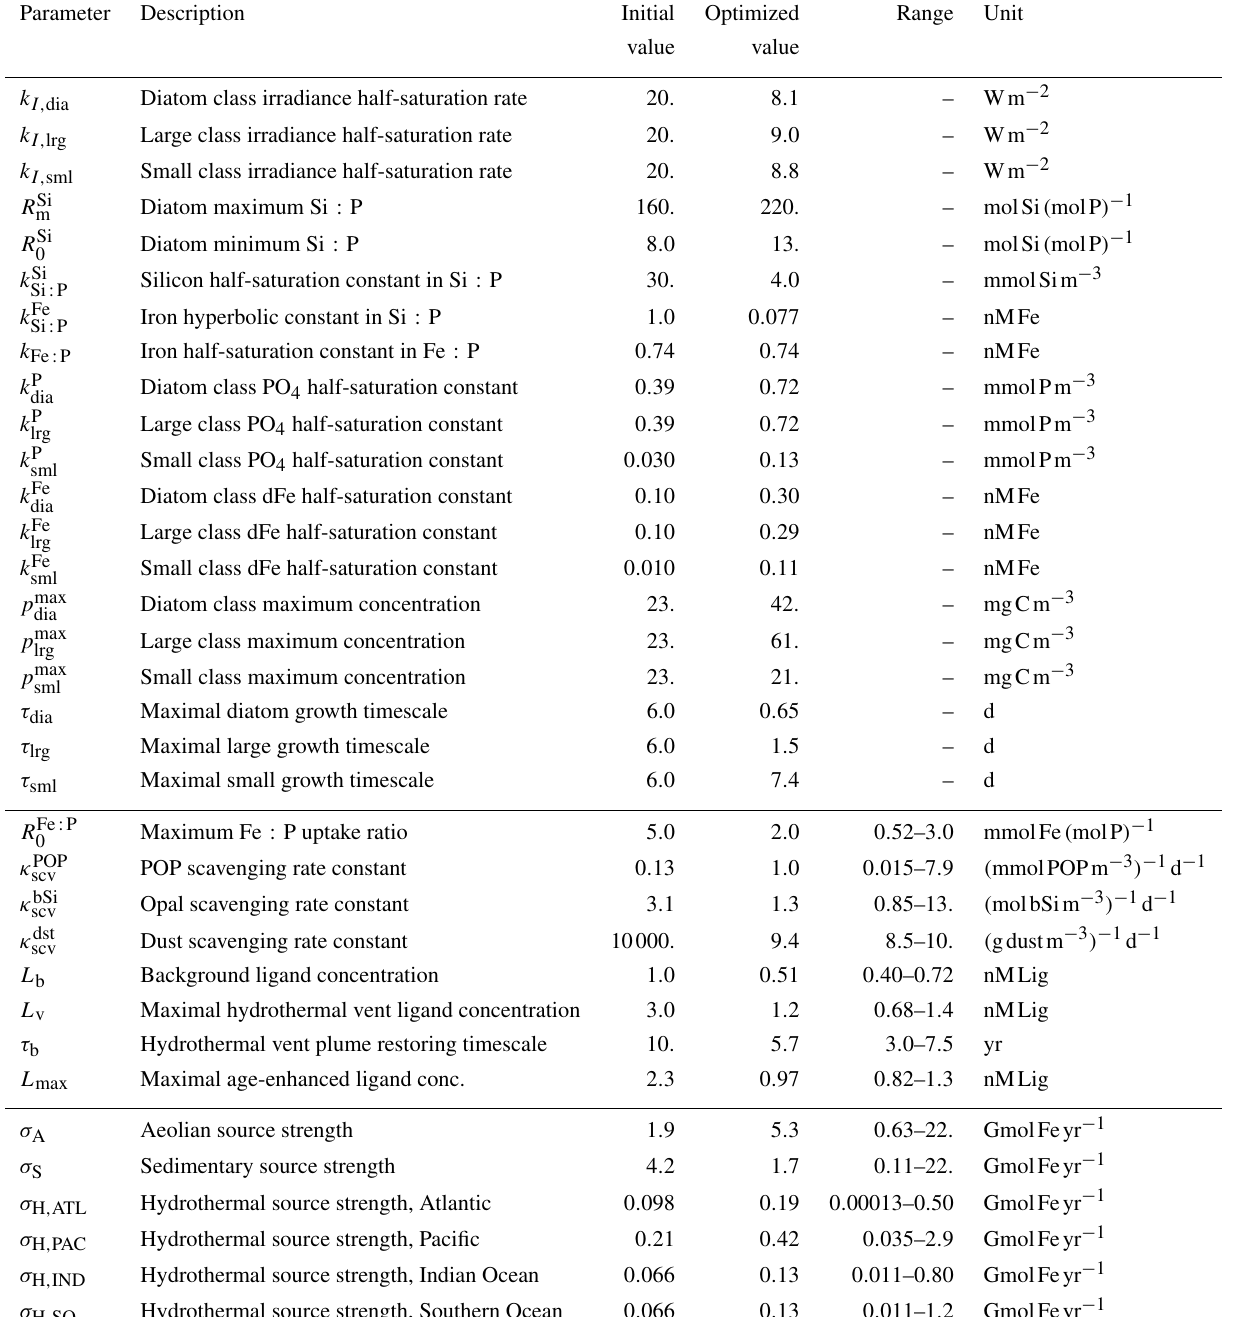
Table 2. Optimized parameters and range across family of state estimates.